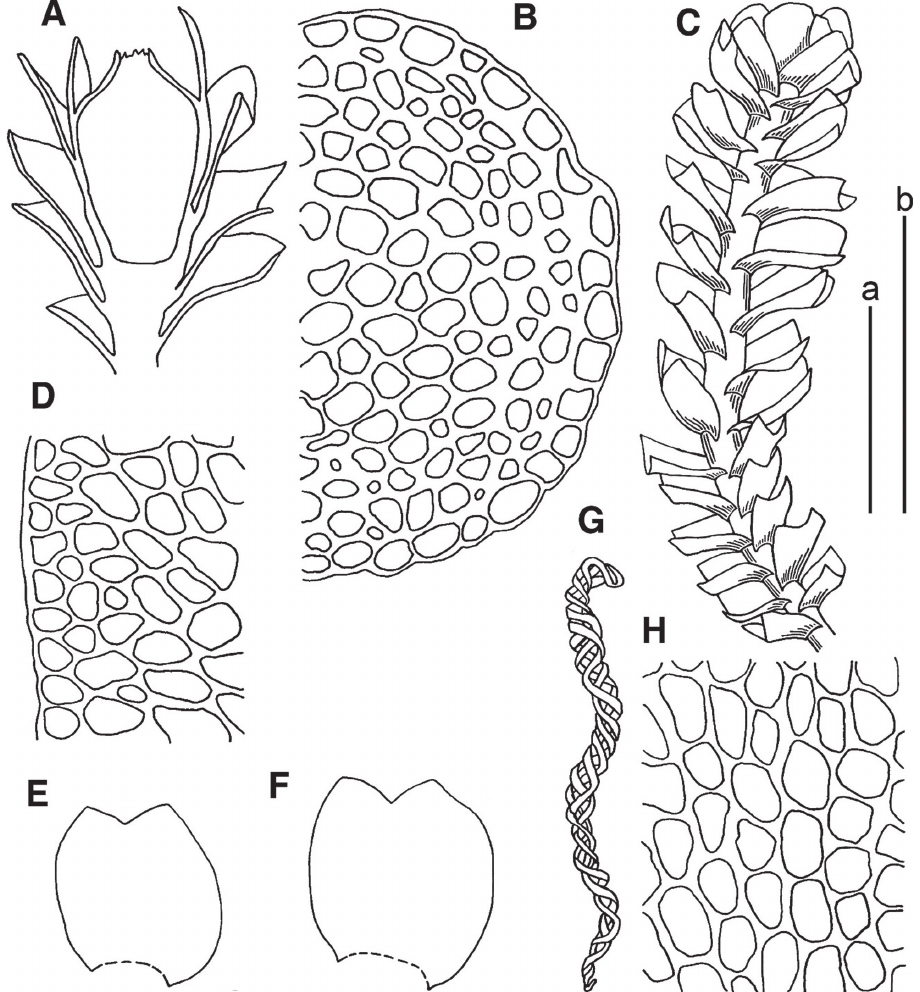
Figure 5. Marsupella tubulosa Steph. A gynoecium longitudinal section B stem cross section (fragment) C plant habit, dorsal view D leaf margin cells E, F leaves G elater, H midleaf cells. Scale bars: 1 mm ( A, C, E, F ); b 100 μm ( B, D, G, H ). All from Choi 3732